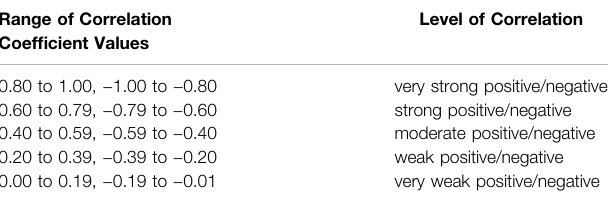
Level of Correlation